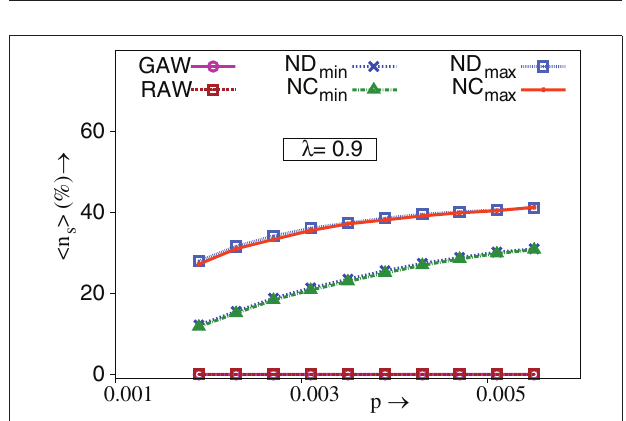
FIGURE 6 | Percentage of ensemble averaged fraction of TIW and strictly adaptive walks that reach the global optimum, χ , vs. p . TIW can be governed by the minimum and maximum value of degree ( ND ), closeness ( NC ) and betweenness ( NB ) of nodes. λ = 0.9, N = 1024, and N E = 40000 with 10 5 walks performed on each network. The standard error is smaller than the size of the data points. All other conditions are as in Figure 2F